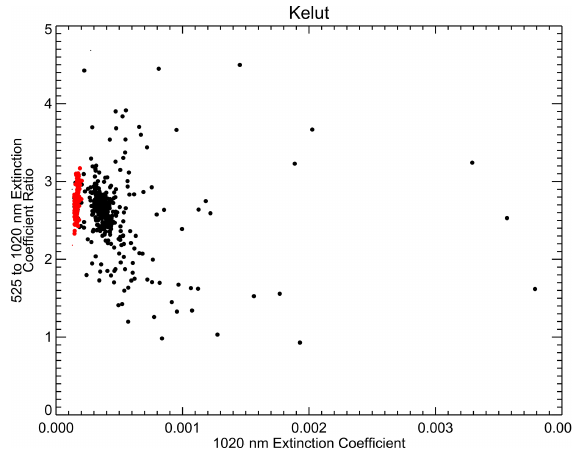
Figure 10. The SAGE II 525 to 1020nm aerosol extinction coeffi- cient ratio plotted versus the 1020nm aerosol extinction coefficient (in km − 1 ) during the Kelut event from December 1989 through Au- gust 1990 plotted at 20.5km between 20 ◦ S and the Equator. Mea- surements occurring before the eruption are colored